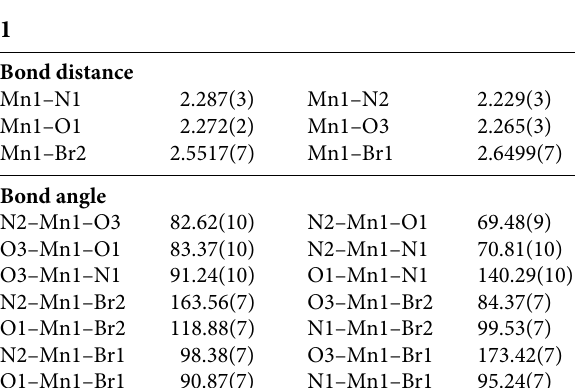
Table 2. Selected bond distances (Å) and bond angles (º) for the complexes.